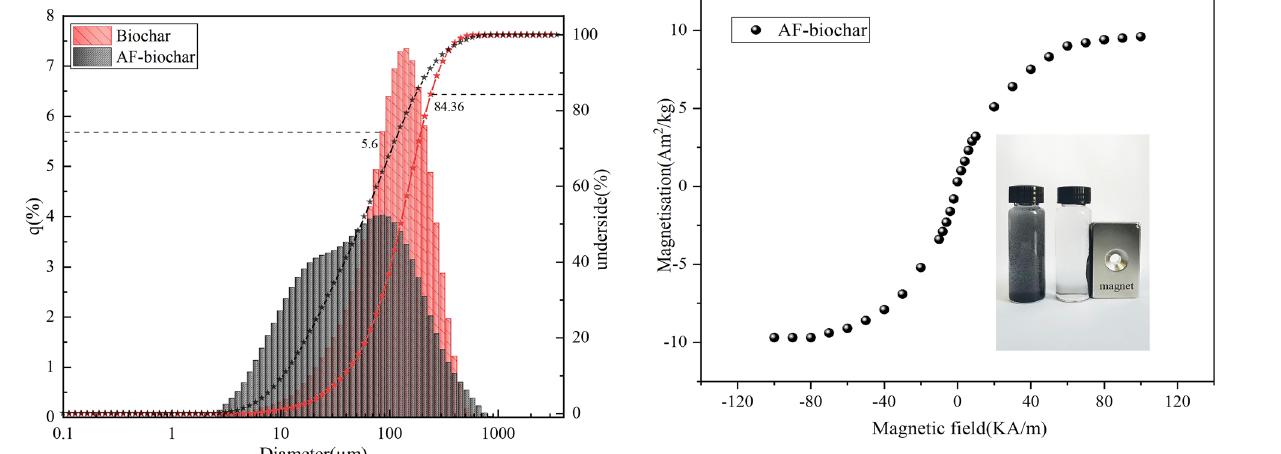
Figure 1: Particle size distribution of AF - biochar and biochar.